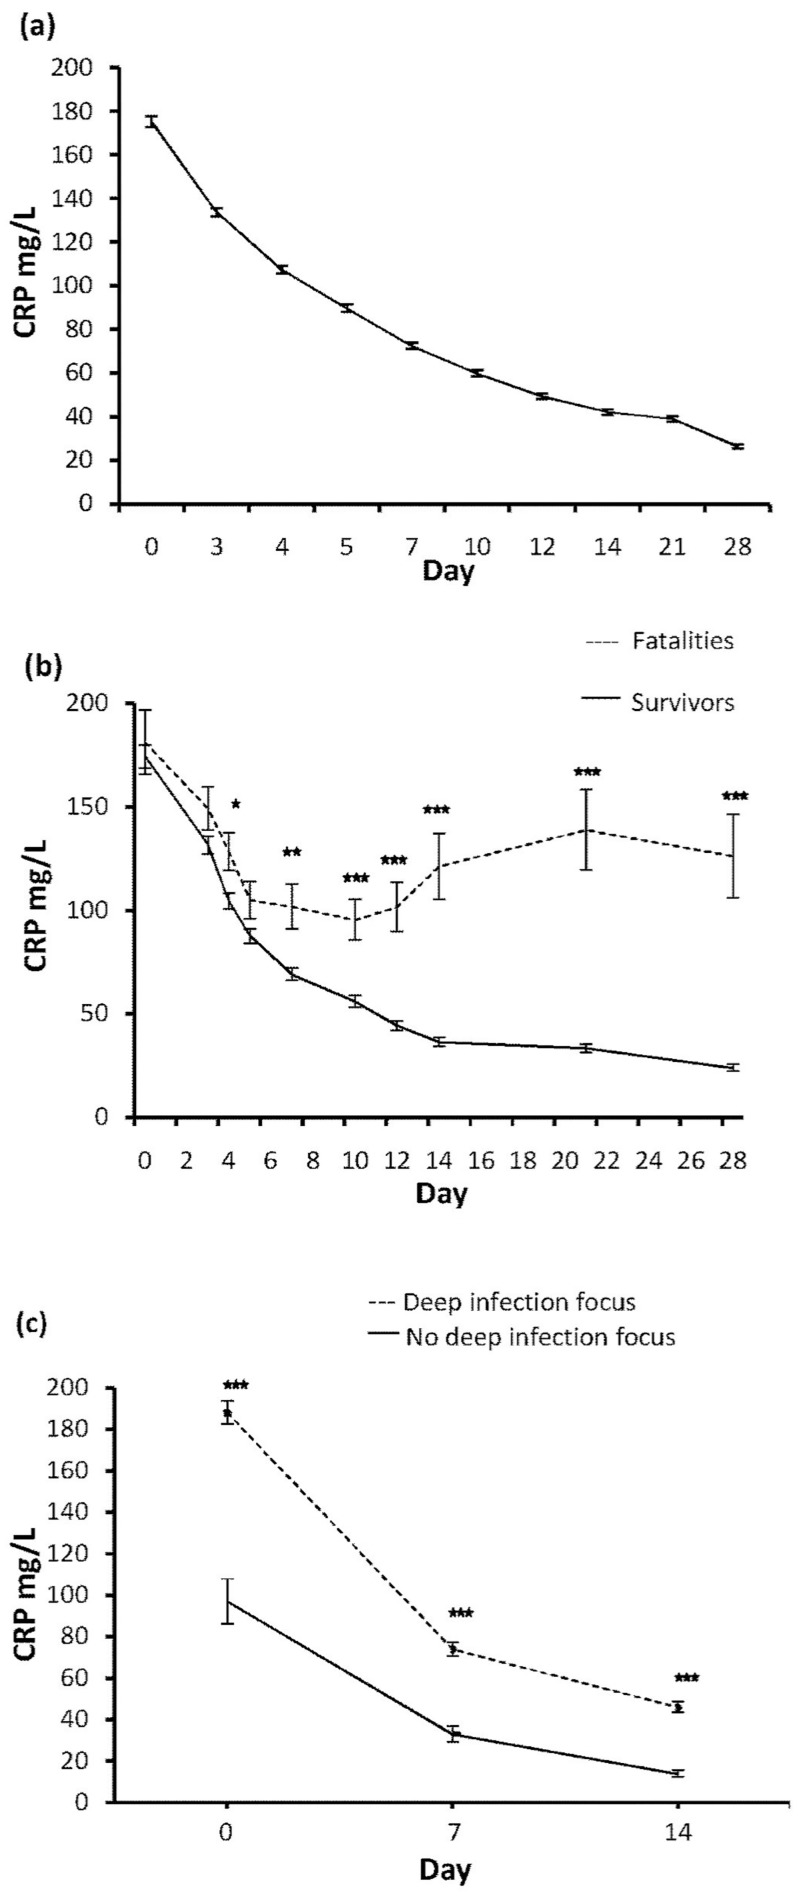
C-reactive protein (CRP) (Mean ±SEM) levels in patients with Staphylococcus aureus bacteremia (SAB) within 30 days of the positive blood culture.(A) All 430 SAB patients. (B) SAB patients with a fatal outcome within 30 days (n = 53) and survivors (n = 377). (C) Mean CRP levels stratified according to the presence (n = 351) or absence (n = 79) of deep infection focus. Stars indicate p-values of the Student’s T-test. * p<0.05, ** p<0.01 and *** p<0.001.